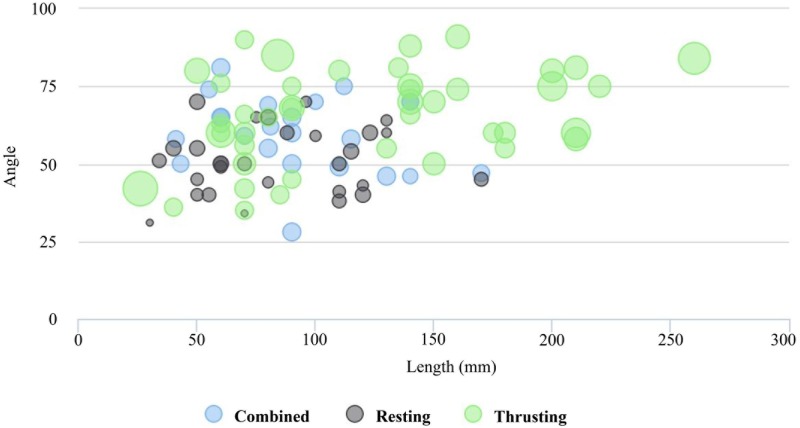
Dihedral functioning according to action.Bubbleplot of edge length (in millimeters) and angle weighted by weighted and grouped by action (mm = millimeters).